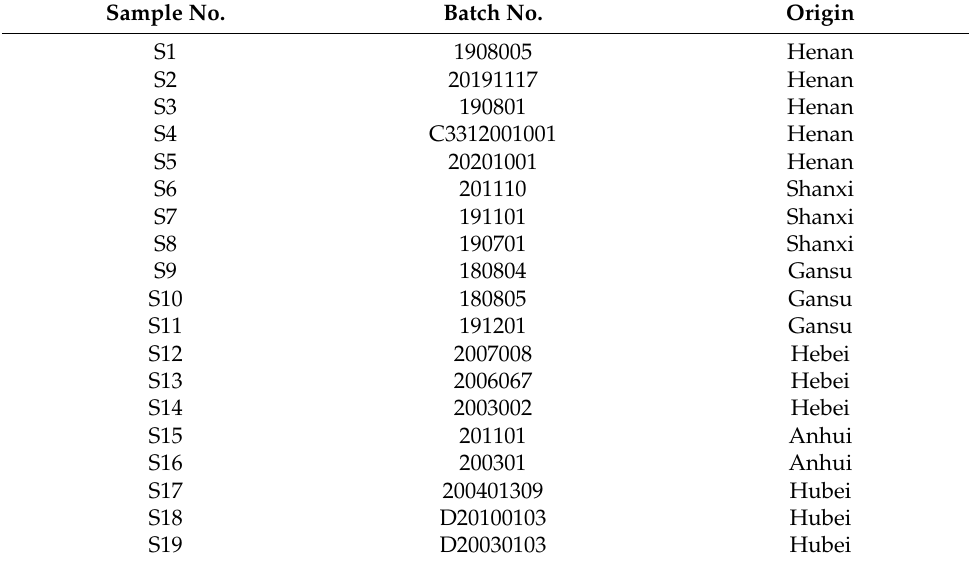
Table 12. Sample information of